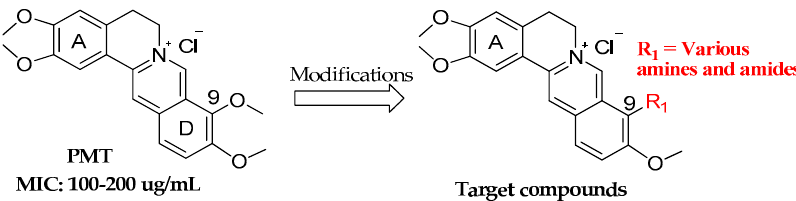
Figure 1. Chemical structure of palmatine (PMT), and structure modification strategy. MIC, minimum inhibitory concentration.